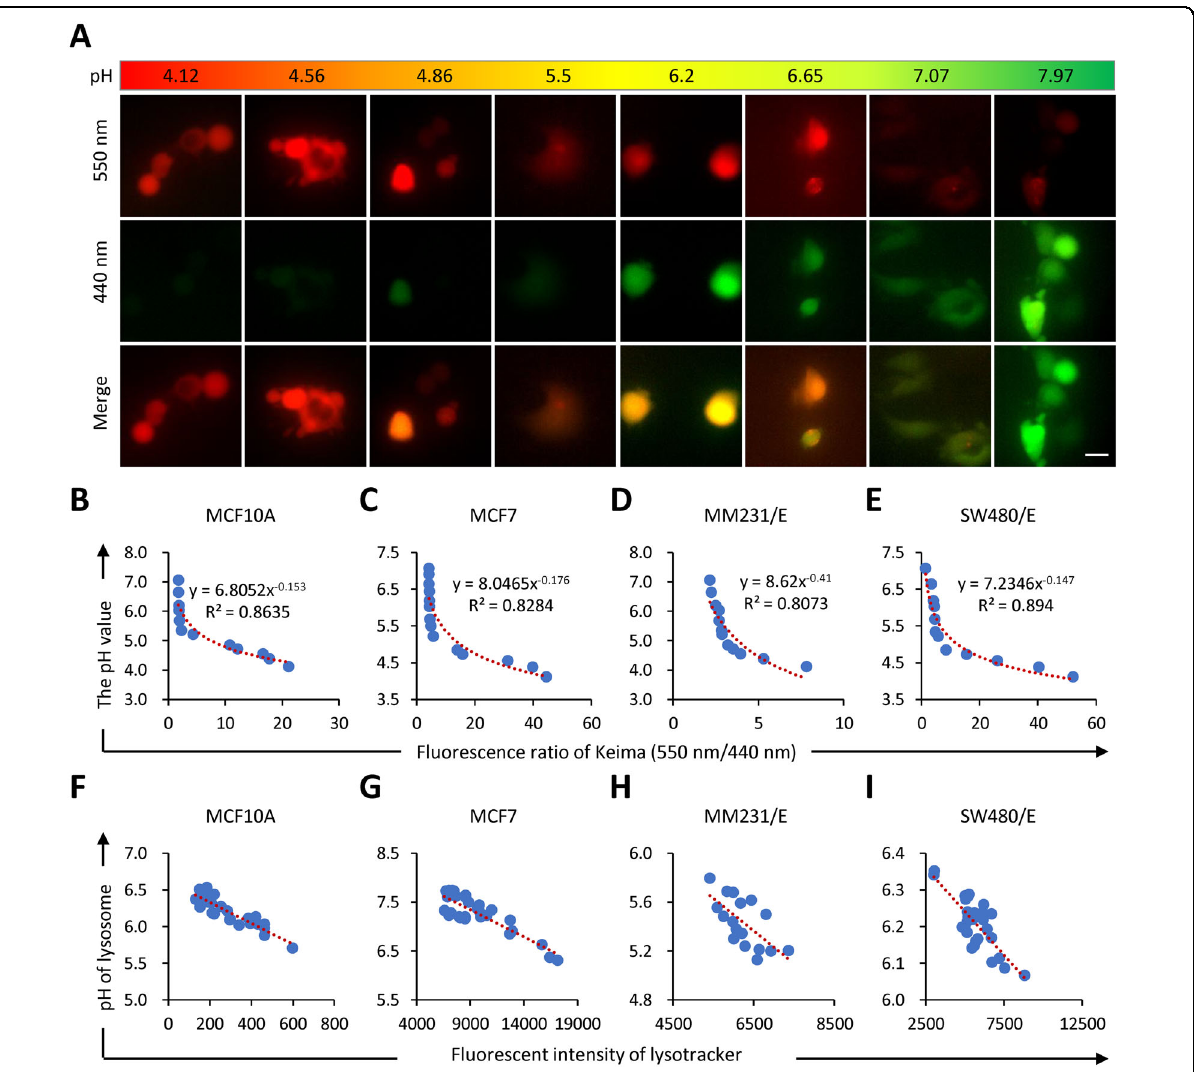
Fig. 1 Probing cellular pH by keima fl uorescent protein. A Representative images of three channels (550 nm, 440 nm, and merged) for keima- overexpressed MCF7 cells in a series of buffers of different pHs. Scale bar, 20 μ m. The cellular pH value was negatively correlated with the excitation ratio of keima (550/440), in MCF10A ( B ), MCF7 ( C ), MDA-MB-231/E ( D ), and SW480/E ( E ), respectively. The lysosomal pH was negatively correlated with the fl uorescent intensity of LysoTracker in MCF10A ( F ), MCF7 ( G ), MDA-MB-231/E ( H ), and SW480/E ( I ),